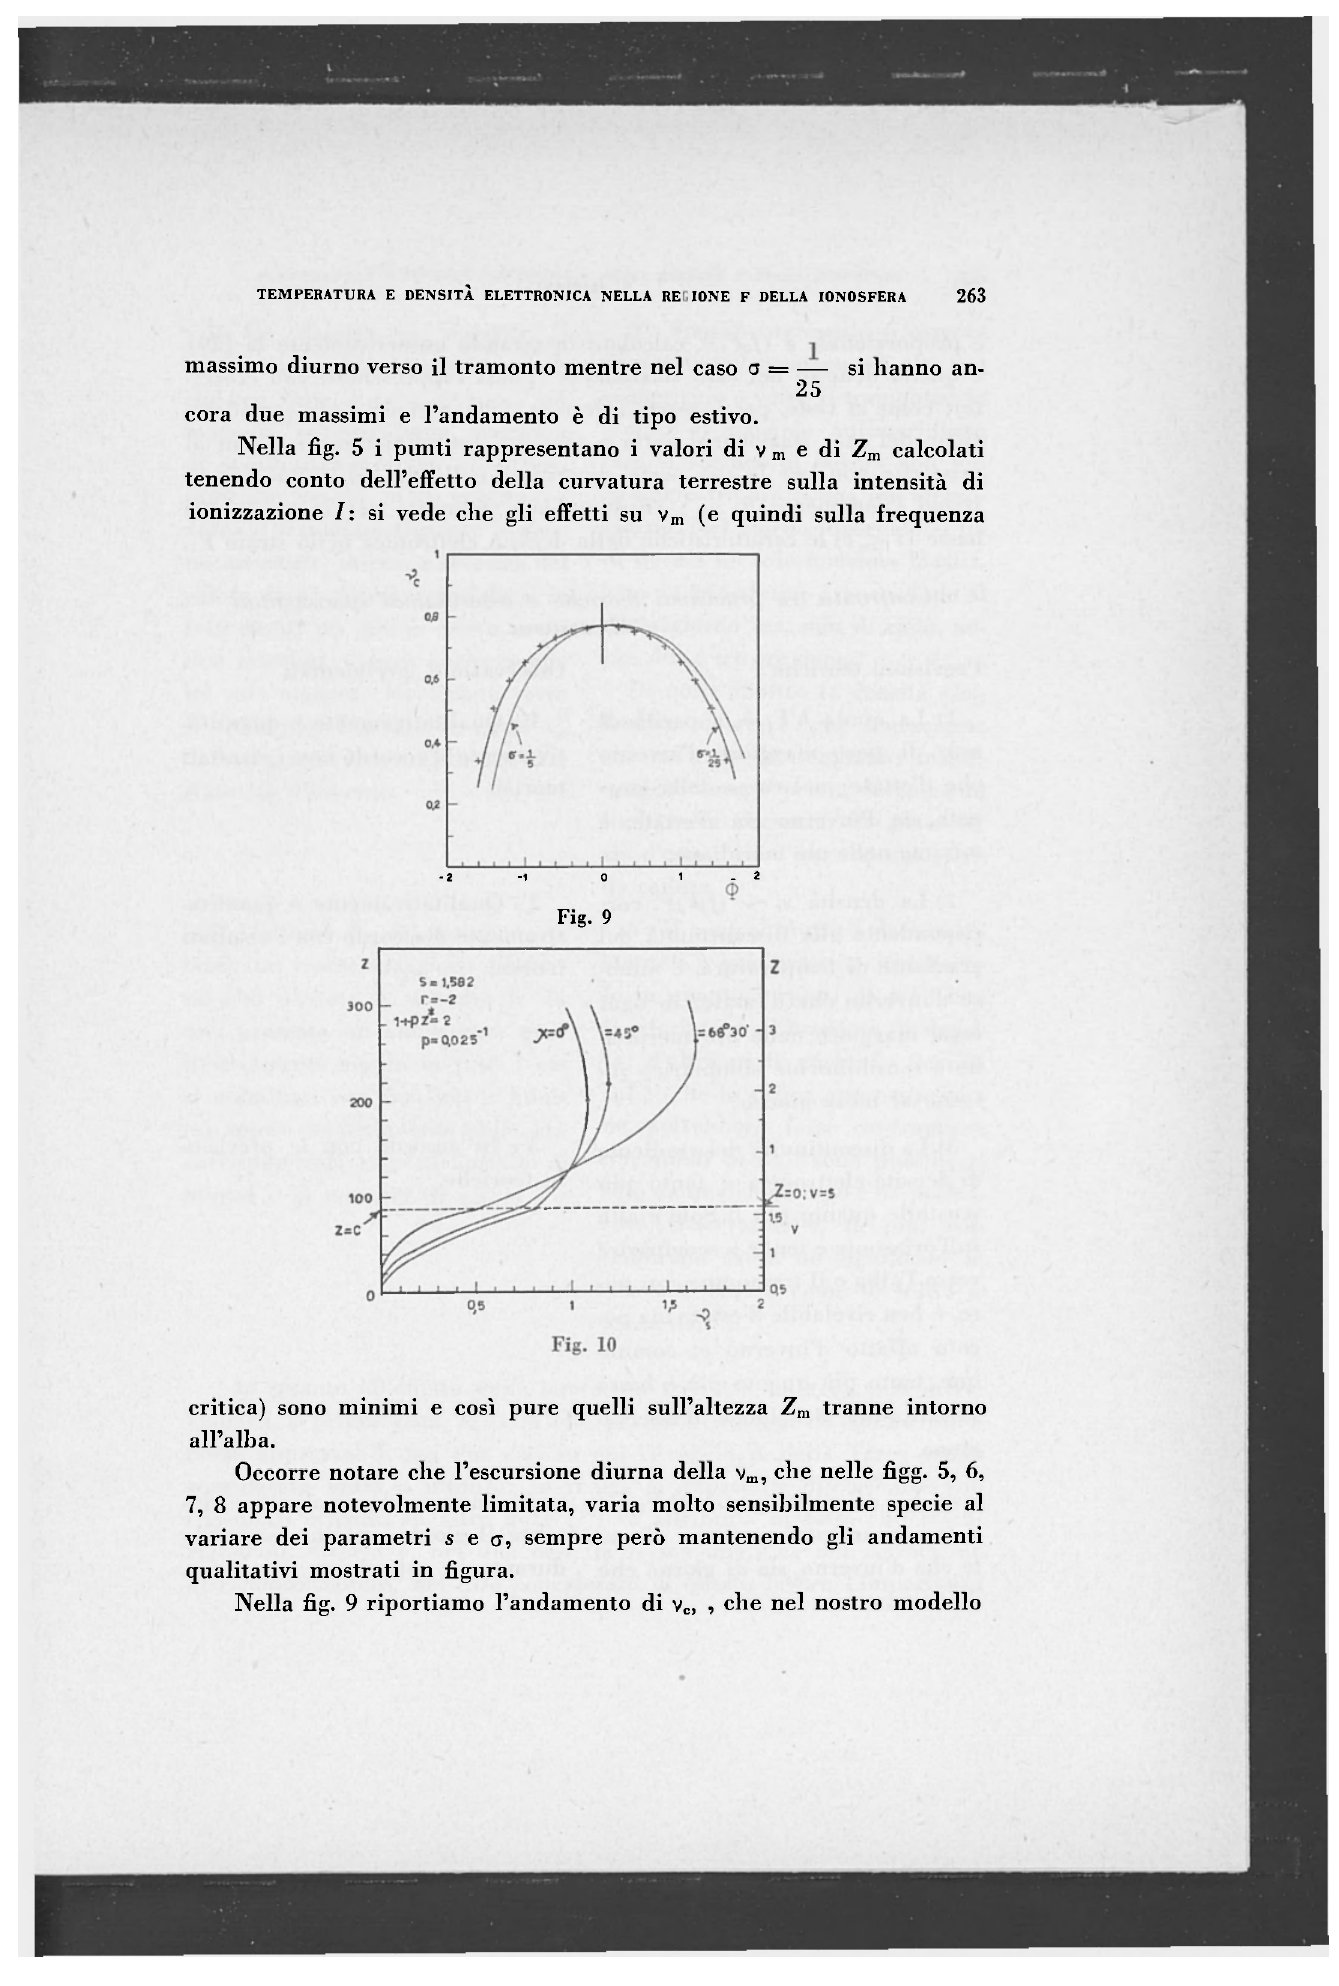
tenendo conto dell'effetto della curvatura terrestre sulla intensità